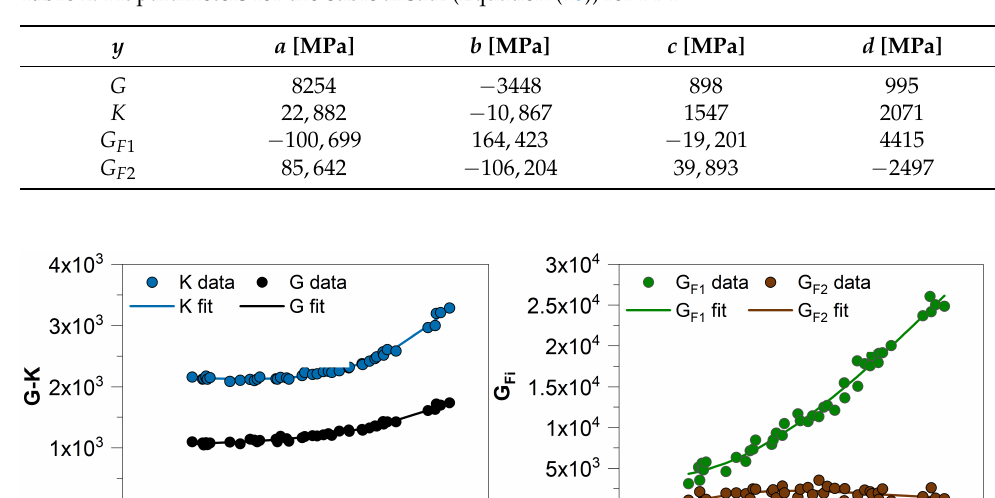
Table 2. Fit parameters for the cubic ansatz (Equation (18)) for PBT.